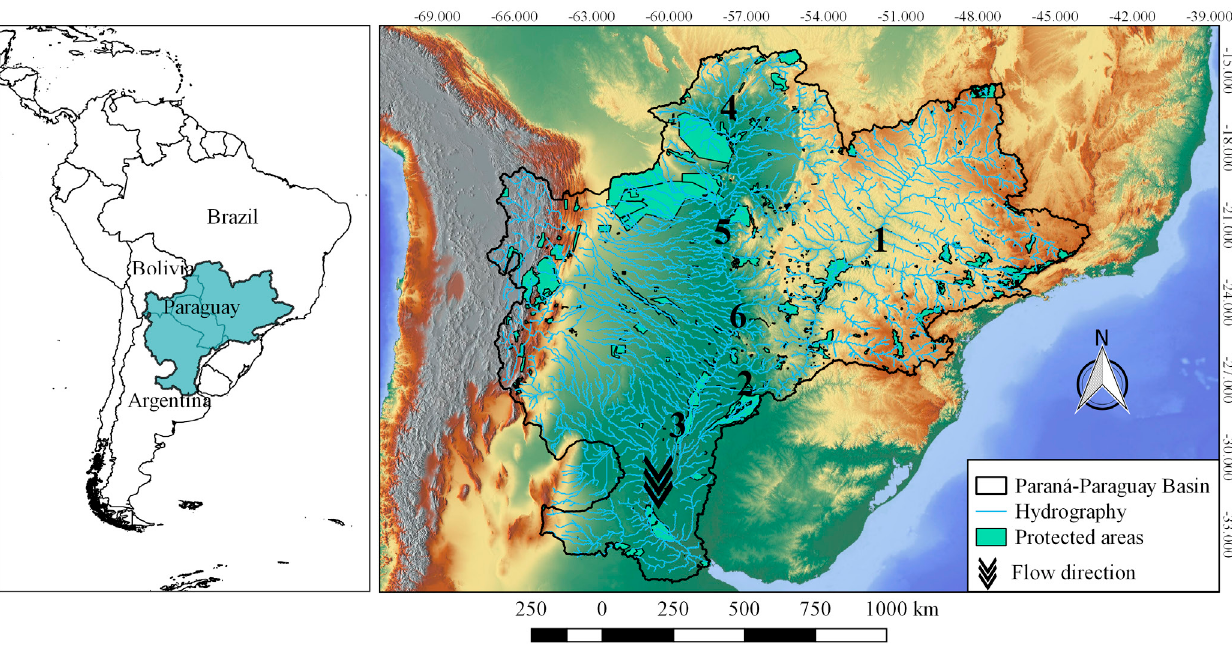
FIGURE 1 | Paraná-Paraguay basin showing countries’ boundaries, topography, hydrographic features, and protected areas. 1. Upper Paraná River basin; 2. Middle Paraná River basin; 3. Lower Paraná basin; 4. Upper Paraguay basin; 5. Middle Paraguay basin; 6. Lower Paraguay